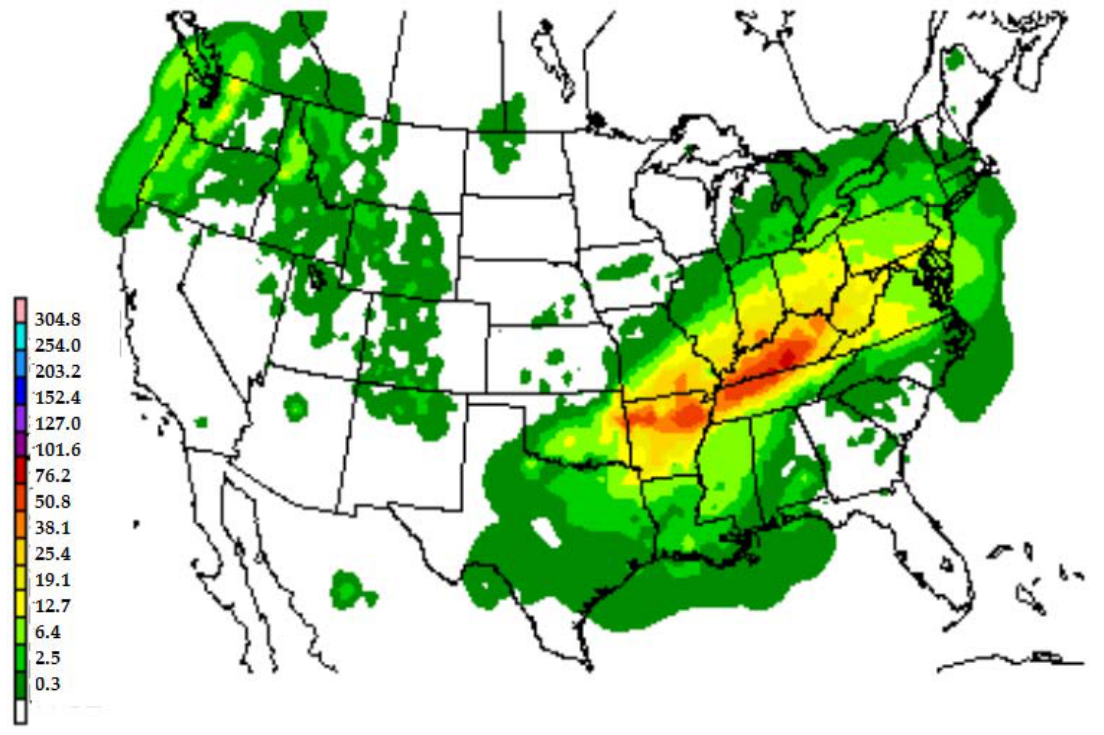
Figure 4. Contoured 24 h precipitation (mm) ending at 1200 UTC 28 January 2009